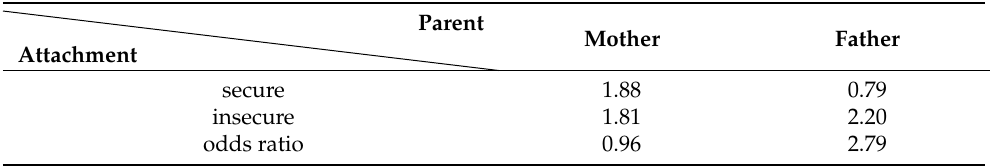
Table 7. Odds for lifetime experience of attempting suicide according to security of attachment to mother and father and odds ratio for lifetime experience of attempting suicide.